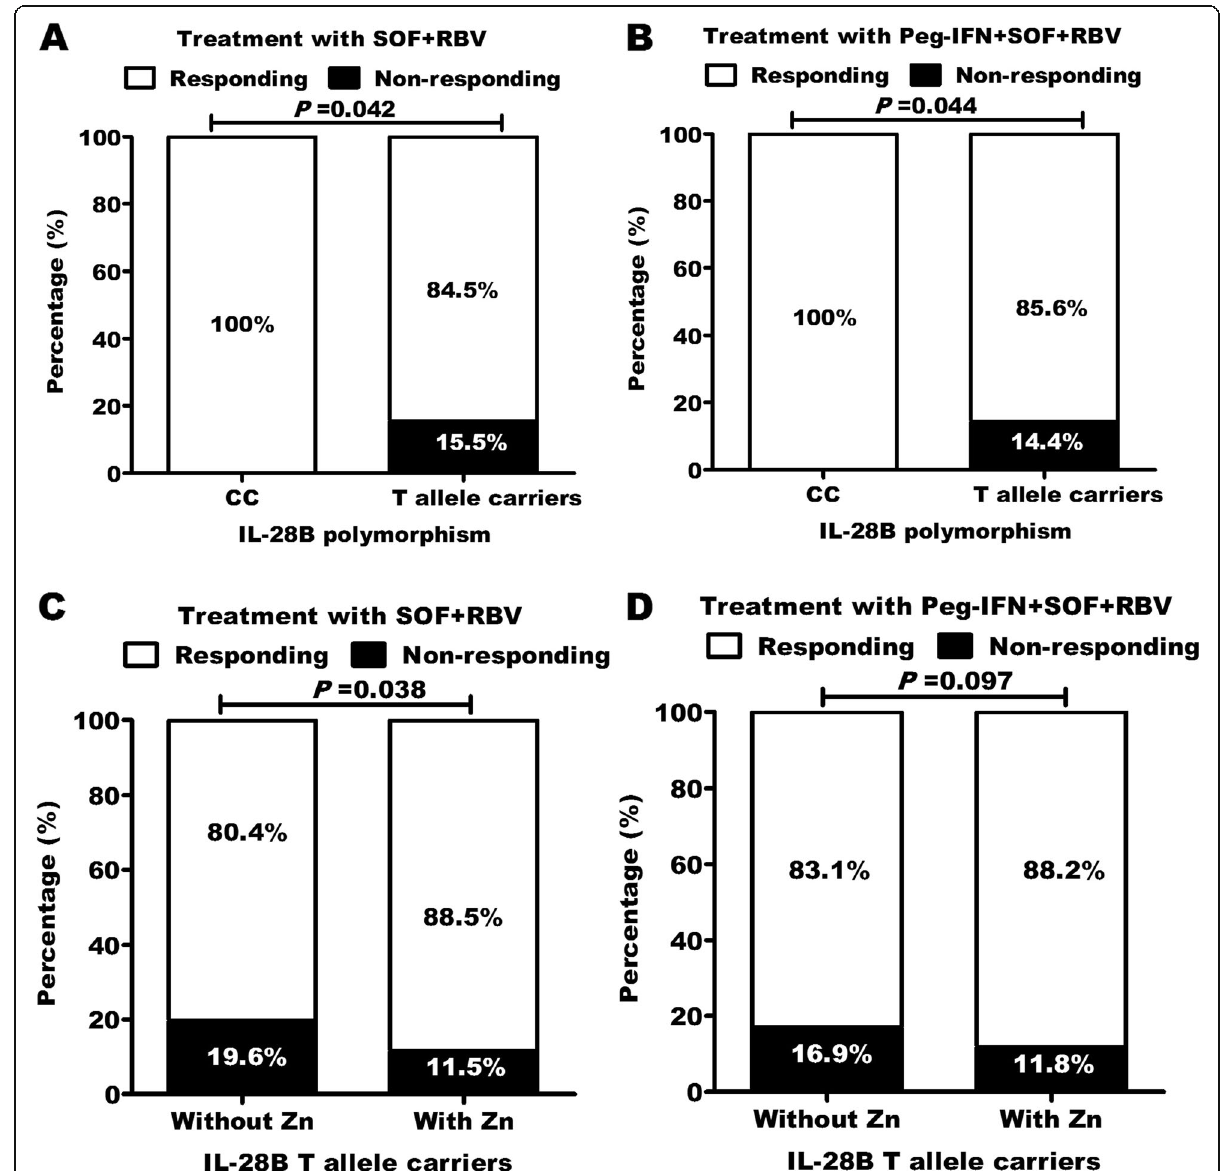
Fig. 1 IL28B rs12979860 single-nucleotide polymorphism is linked to virologic response after treatment with direct-acting antiviral plus pegylated interferon/ribavirin. All patients (100%) with CC genotype achieved HCV-RNA < 25 IU/ml response after treatment with SOF/RBV with and without Peg-INF. In return, T allele carriers achieved HCV-RNA < 25 IU/ml response in A 84.5% after treatment with SOF/RBV and B 85.6% after treatment with SOF/RBV + Peg-INF. Administration of zinc improved virologic response after treatment with both C SOF/RBV and D SOF/RBV + Peg-INF. IL- 28B rs12979860 single-nucleotide polymorphism genotypes. T allele carriers = CT/TT